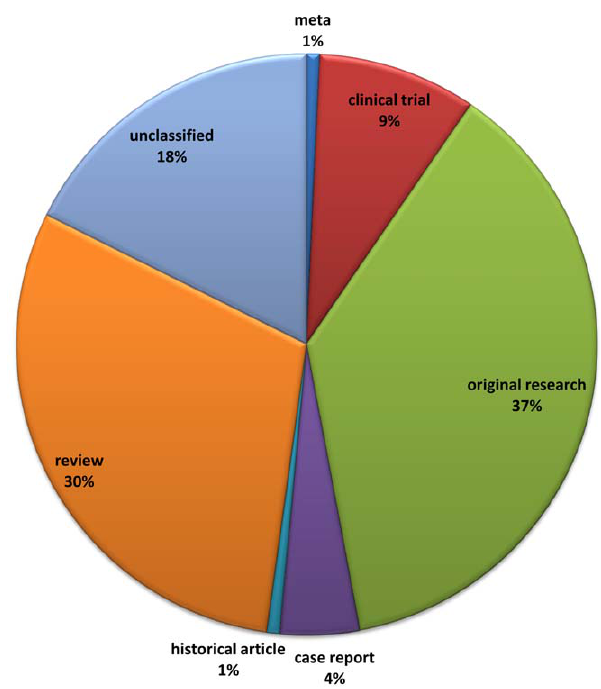
Figure 8. Medline annotation of studies provided by U.S. Food and Drug Administration (FDA; n=136) as references for ‘‘approved biomarkers.’’